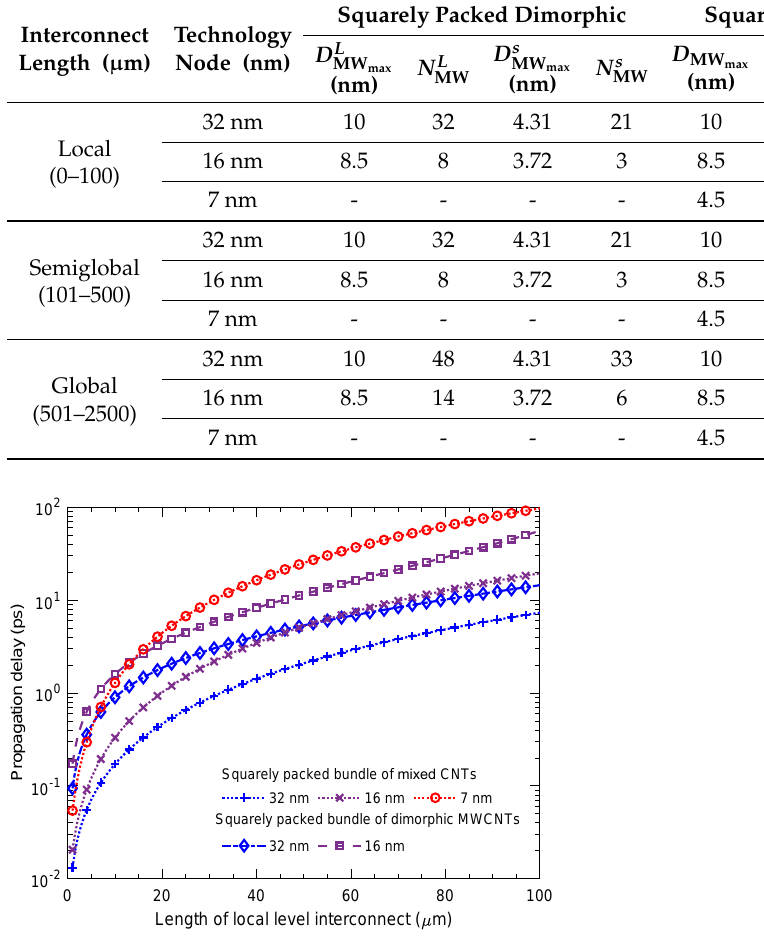
Figure 7. Comparison of delay performance of a squarely packed bundle of mixed CNTs and that of dimorphic MWCNTs for local-level interconnect lengths. The size and number of accommodated CNTs for different technology nodes are mentioned in Table 1.